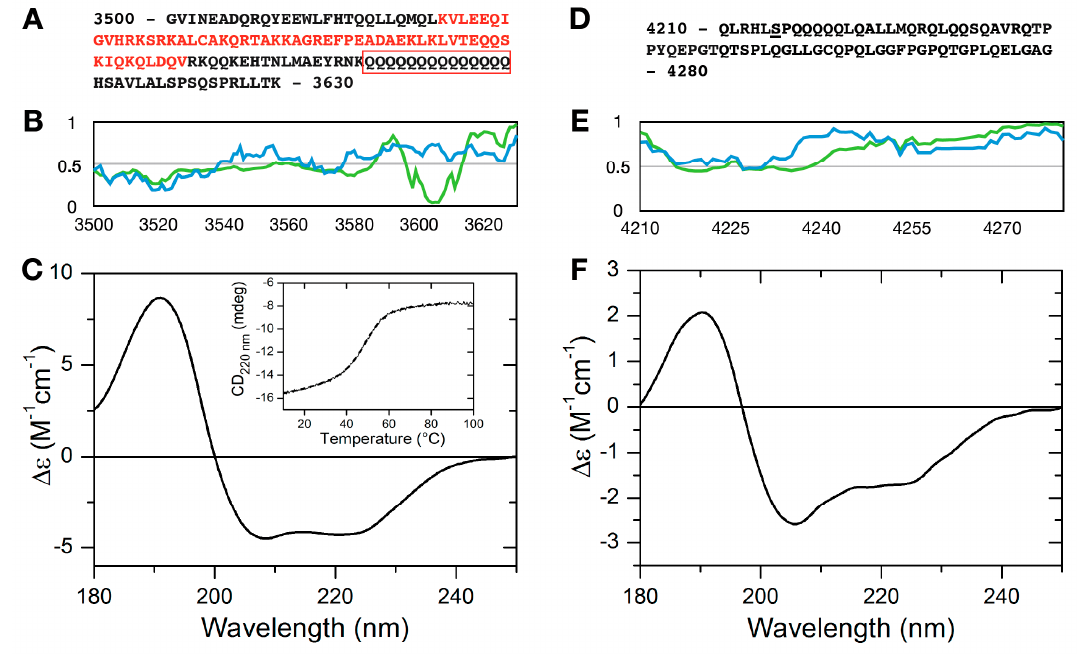
Figure 1. Structural characterization of the MLL4 regions. Sequences of MLL4 3500–3630 ( A ) and MLL4 4210–4280 ( D ). Predicted RNA binding region is indicated by red letters and the polyQ stretch is framed with red. IUPRed (blue) and Anchor (green) prediction of MLL4 3500–3630 ( B ) and MLL4 4210–4280 ( E ). Residues having an IUPred score above 0.5 are considered to be disordered, while residues with an Anchor score below 0.5 constitute predicted binding sites. Far-UV CD spectra of MLL4 3500–3630 ( C ) and MLL4 4210–4280 ( F ). Inset: temperature-dependent changes in the structure of MLL4 3500–3630 as observed by monitoring the changes in the absorbance at 220 nm.